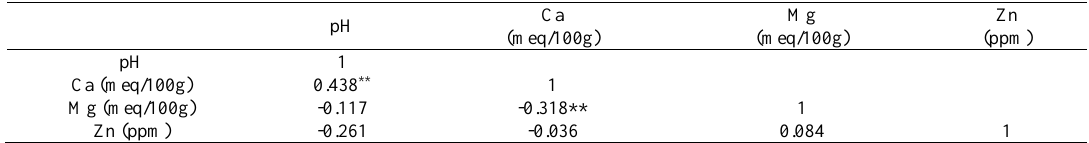
Table 3. Correlation between pH, Ca, Mg and Zn